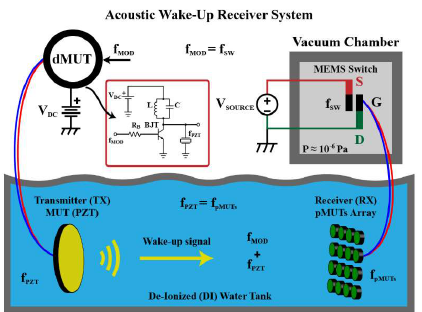
Figure 23. Acoustic wake-up microsystem in Architecture 4 [72].